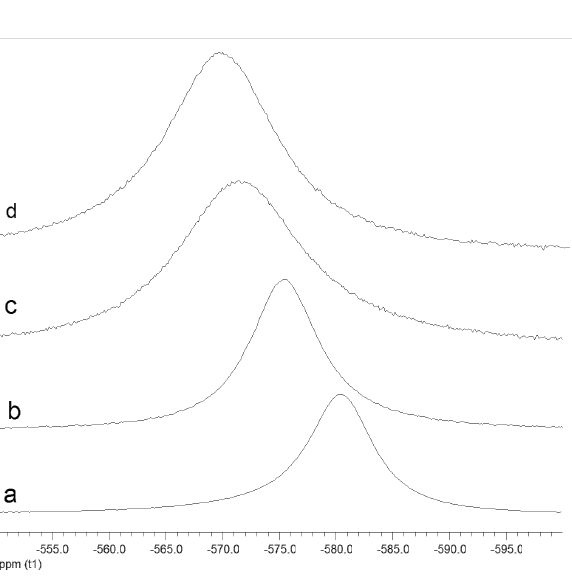
( Δ H ‡ ) can then be obtained from the slope of the best-fit line from the data plotted in Figure 4 and was found to be 67.8